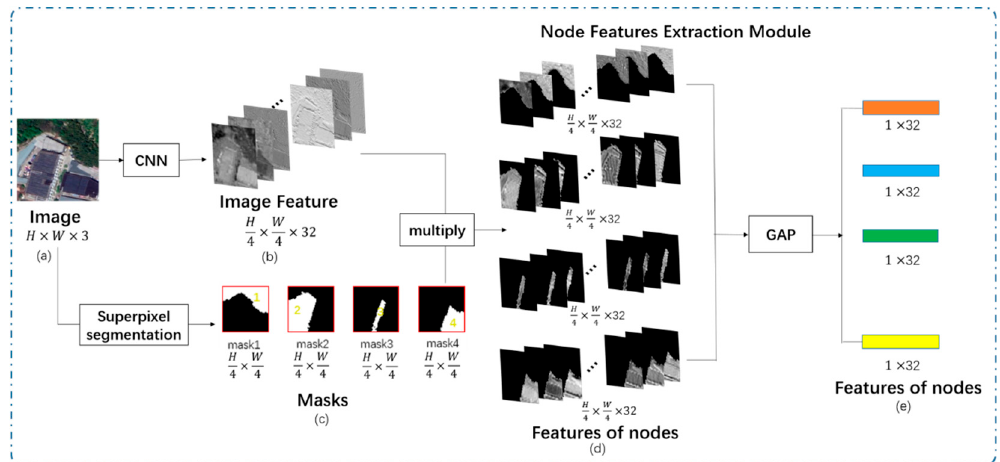
Figure 8. The structure of the node feature extraction module. ( a ) is the original image; ( b ) is the image feature; ( c ) are resized masks; ( d ) are two-dimensional features of nodes; ( e ) are one-dimensional features.